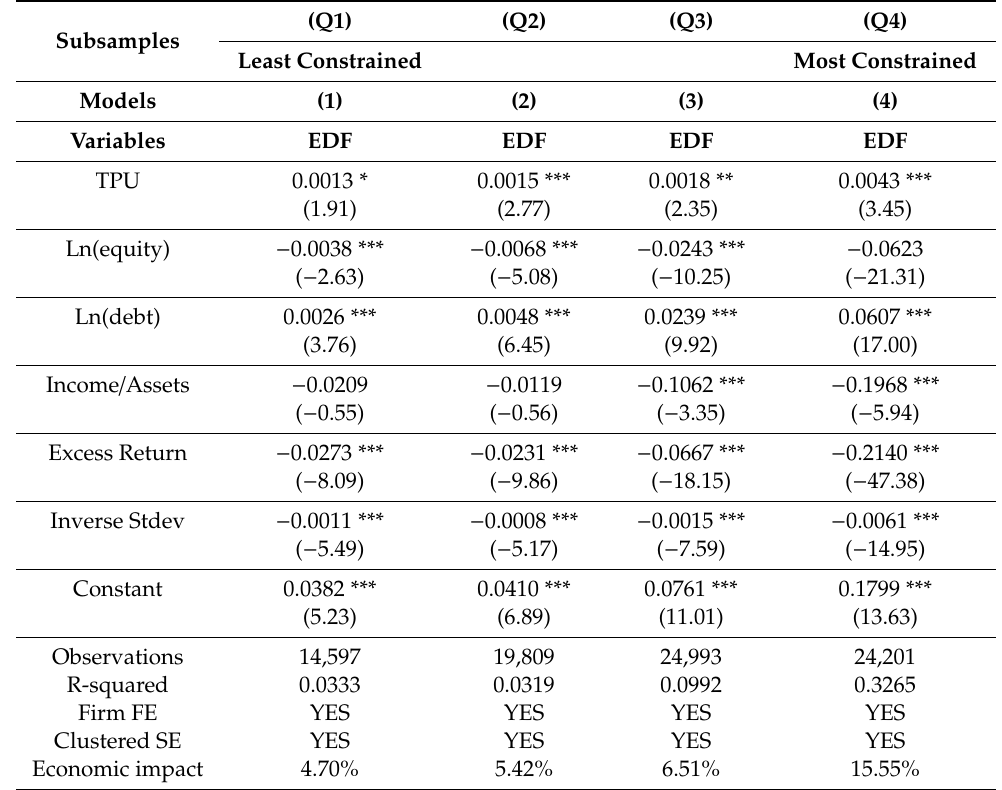
Table 5. Impact of tax policy uncertainty on default risk conditioned on financial constraints—this table presents firm fixed e ff ects regression results for the impact of tax policy uncertainty on default risk. The sample has 9888 unique firms from 1987 to 2019. In all models, the dependent variable is the expected default frequency ( EDF ). The main variable of interest tax policy uncertainty (TPU). All variables are defined in Appendix A. The subsamples are defined into quartiles by the measure of financial constraints as in (Kaplan and Zingales 1997). The economic impact panel reports the economic impact of a standard deviation increase in TPU on default risk on a relative basis. T -statistics reported in parentheses are calculated using standard errors that are clustered at the firm level and are robust to heteroskedasticity. Symbols *, **, and *** indicate statistical significance at 10%, 5%, and 1% levels,